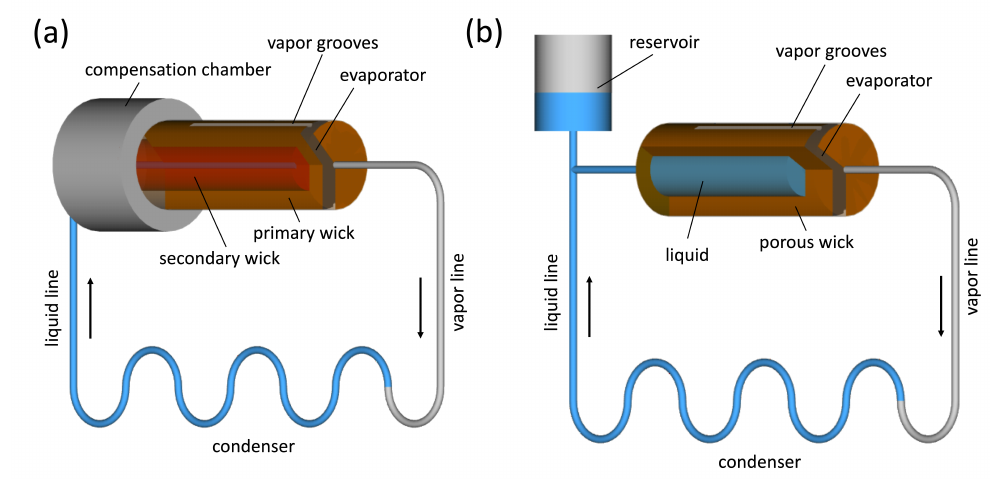
Figure 6. Schematic of a loop heat pipe ( a ), and a capillary-pumped loop heat pipe ( b )